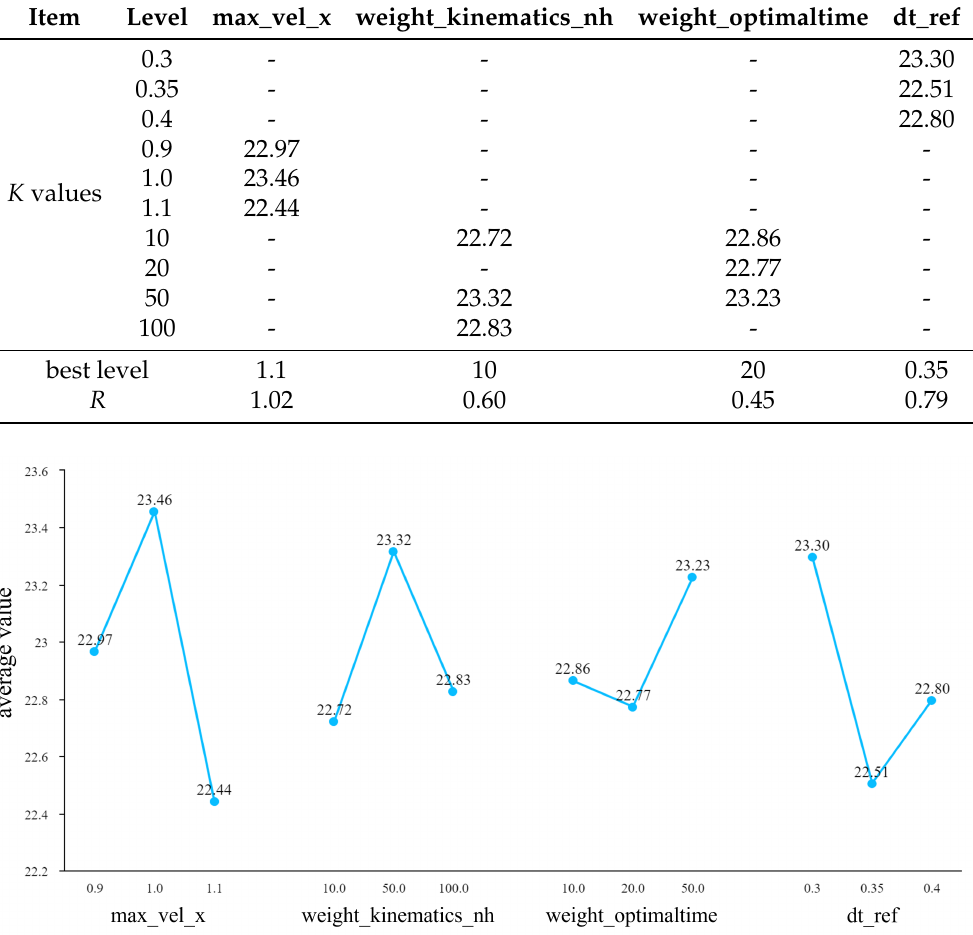
Figure 6. The means of each level of the